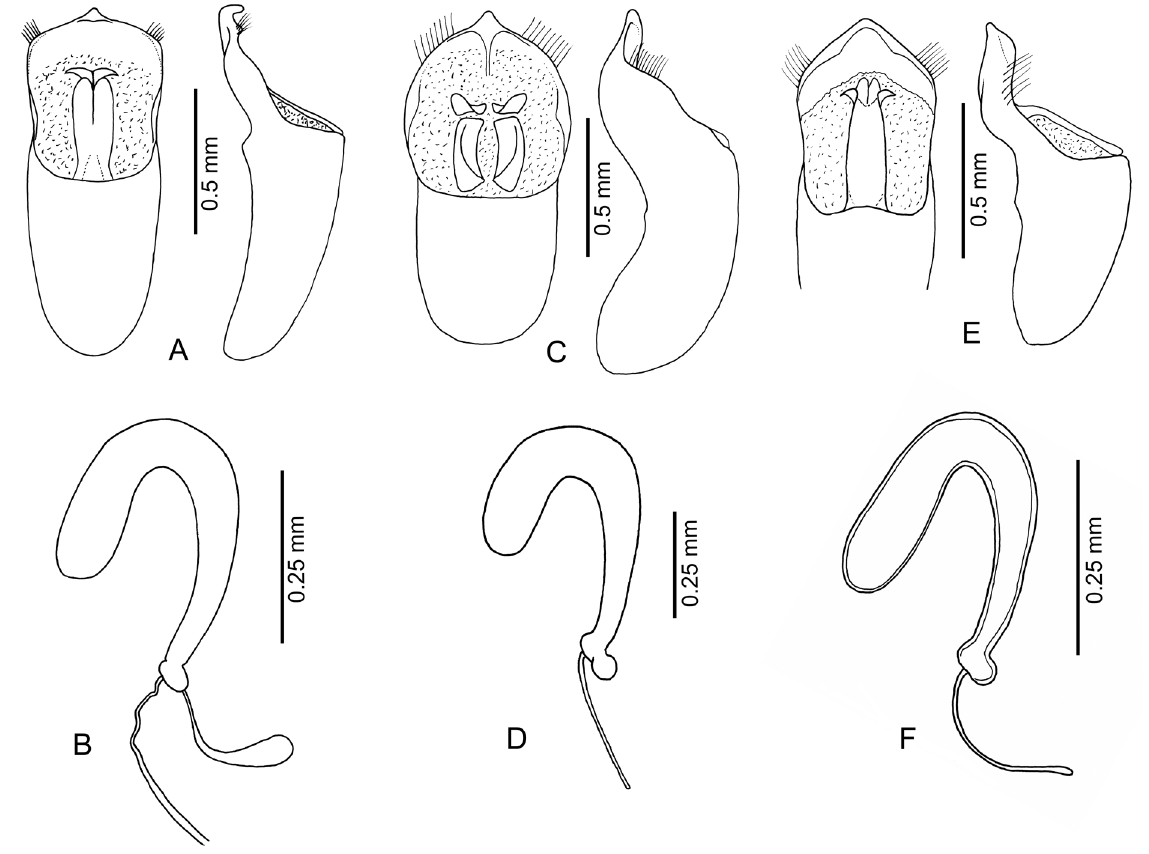
Fig. 5. A – B . Tituboea friedmani Bezděk sp. nov. A . Aedeagus in dorsal and lateral views. B . Spermatheca. C – D . T. chobauti (Pic, 1896). C . Aedeagus in dorsal and lateral views. D . Spermatheca. E – F . T. atriceps Pic, 1924. E . Aedeagus in dorsal and lateral views. F .